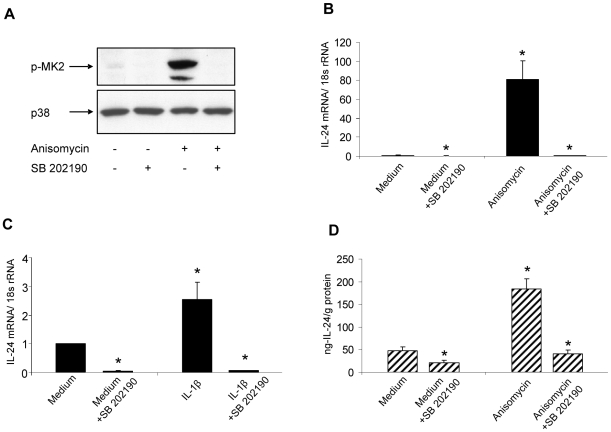
Inhibition of p38 MAPK activation abrogates IL-24 expression.(A) Whole cell extracts were prepared from NHEK incubated with or without (control) anisomycin (300 ng/ml) for 30 minutes in the absence or presence of the 38 MAPK inhibitor SB 202190 (10 µM). Proteins were separated by SDS-PAGE. After electroblotting, separated proteins were probed with anti-phospho-MK2 (recognizing the phosphorylated form of MK2 isoforms 1 and 2) and anti-total p38 MAPK. A gel representative of three different experiments is shown. NHEK were cultured with or without SB 202190 (10 µM) for 30 minutes before incubation with (B) anisomycin (300 ng/ml) or medium control for 4 hours or (C) IL-1β (10 ng/ml) or medium control for 2 hours. Total RNA was extracted and IL-24 mRNA (relative to housekeeping gene 18 s RNA) levels were determined. *p<0.05 compared with medium control (n = 5 cultures). Bars indicate mean ± SD. (D) NHEK were cultured in the presence or absence of SB 202190 (10 µM) with medium control or anisomycin (300 ng/ml) for 18 hours. Using ELISA IL-24 concentration in the supernatants was determined and subsequently normalized to the total protein concentration of whole cell extracts. *p<0.05 compared with medium control (n = 5 cultures). Bars indicate mean ± SD.